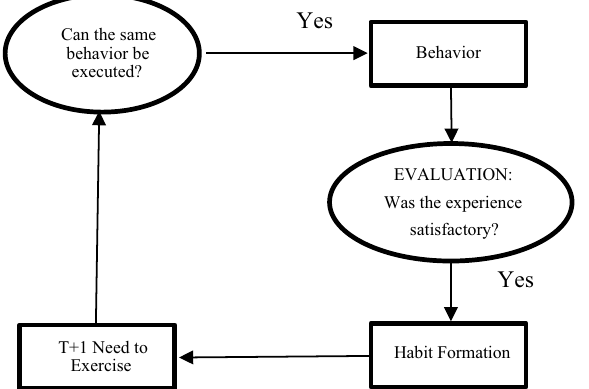
Figure 1. Formation Processes of a (Physical Exercise)